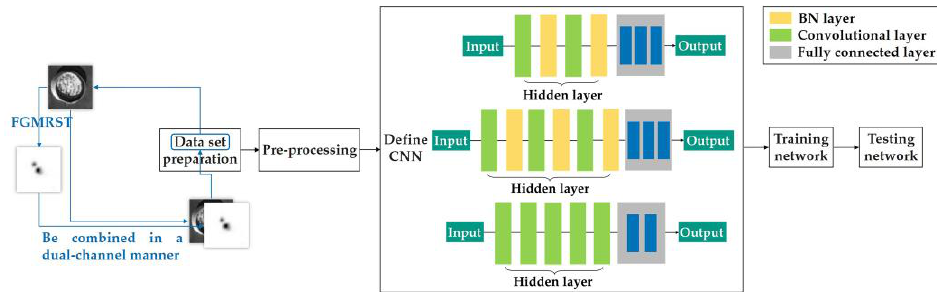
Figure 12. Flow chart of dual-channel method.